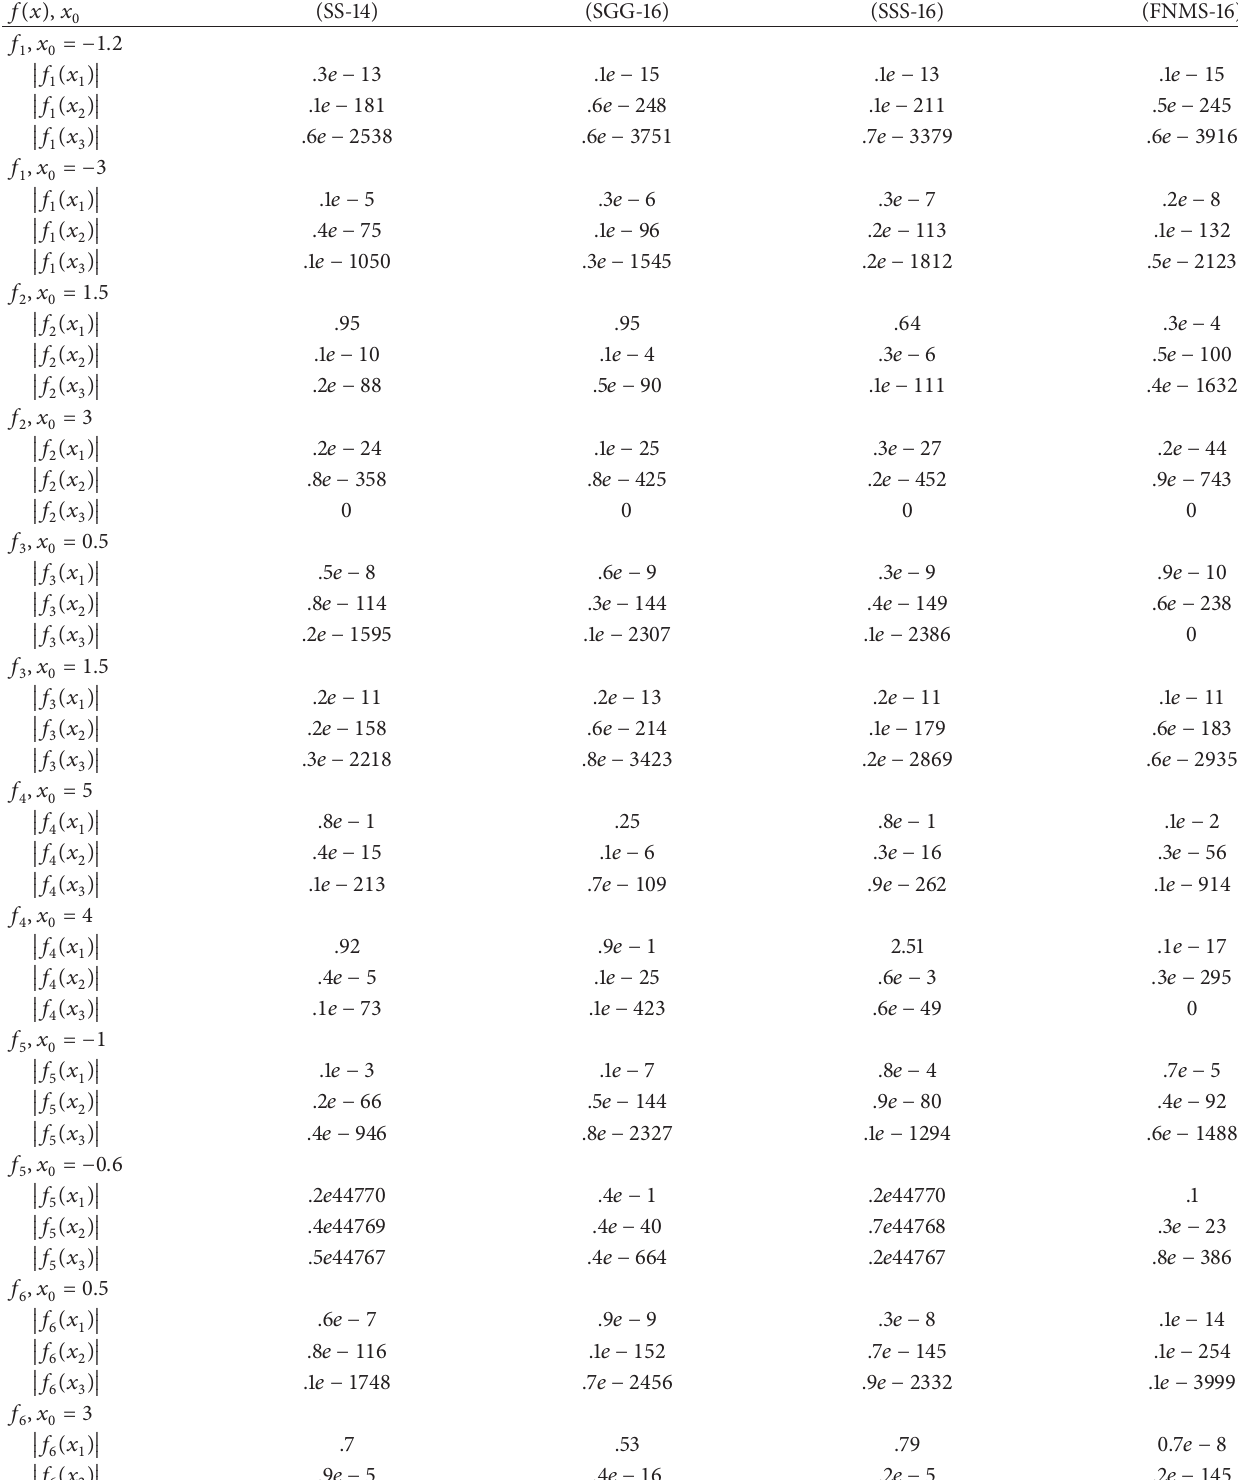
Table 2: Comparison of various iterative